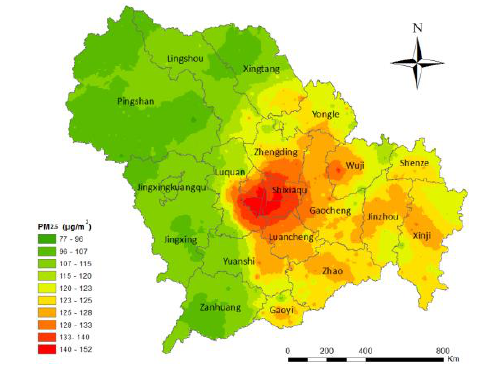
Figure 3. Spatial distribution of PM 2.5